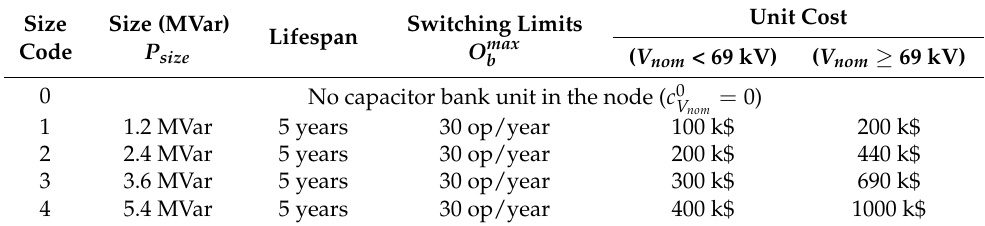
Table 5. Capacitor bank unit data adopted in the case